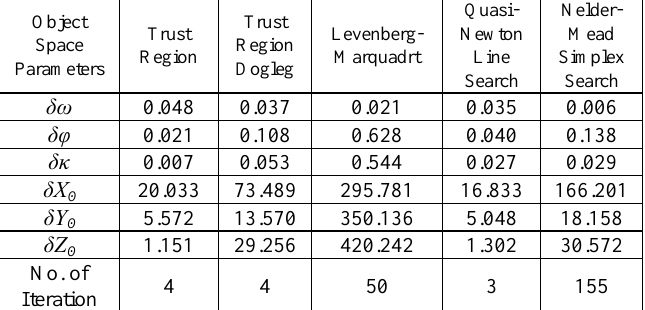
Table 4 Performance of nonlinear least squares methods with φ = 10°